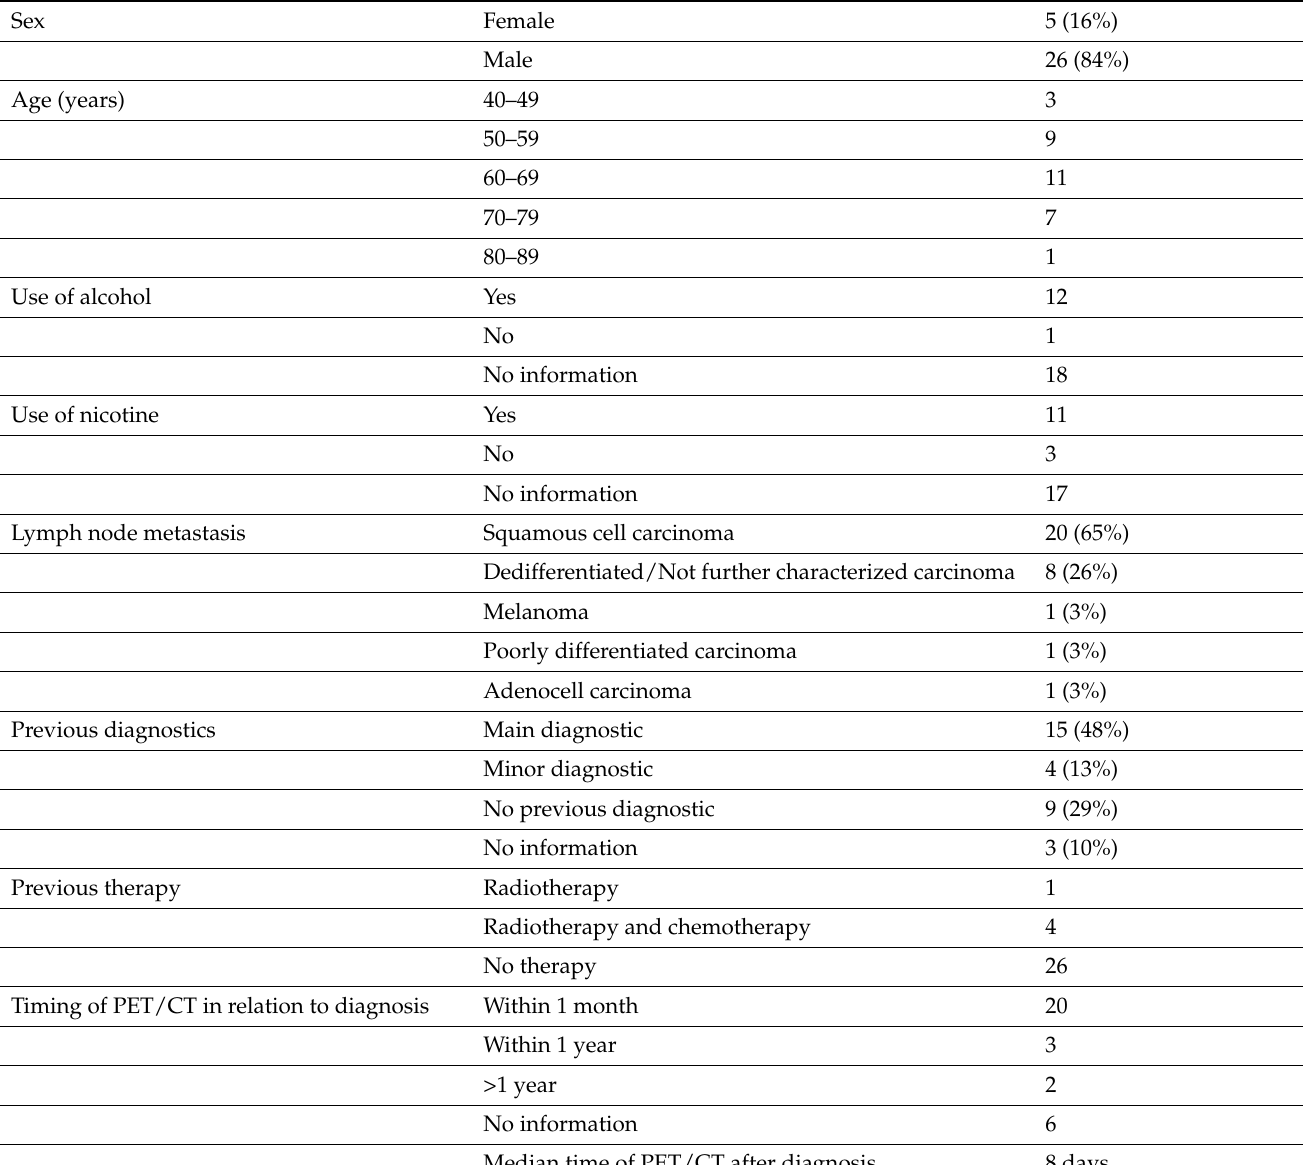
Table 1. Study collective, patient demographics, and